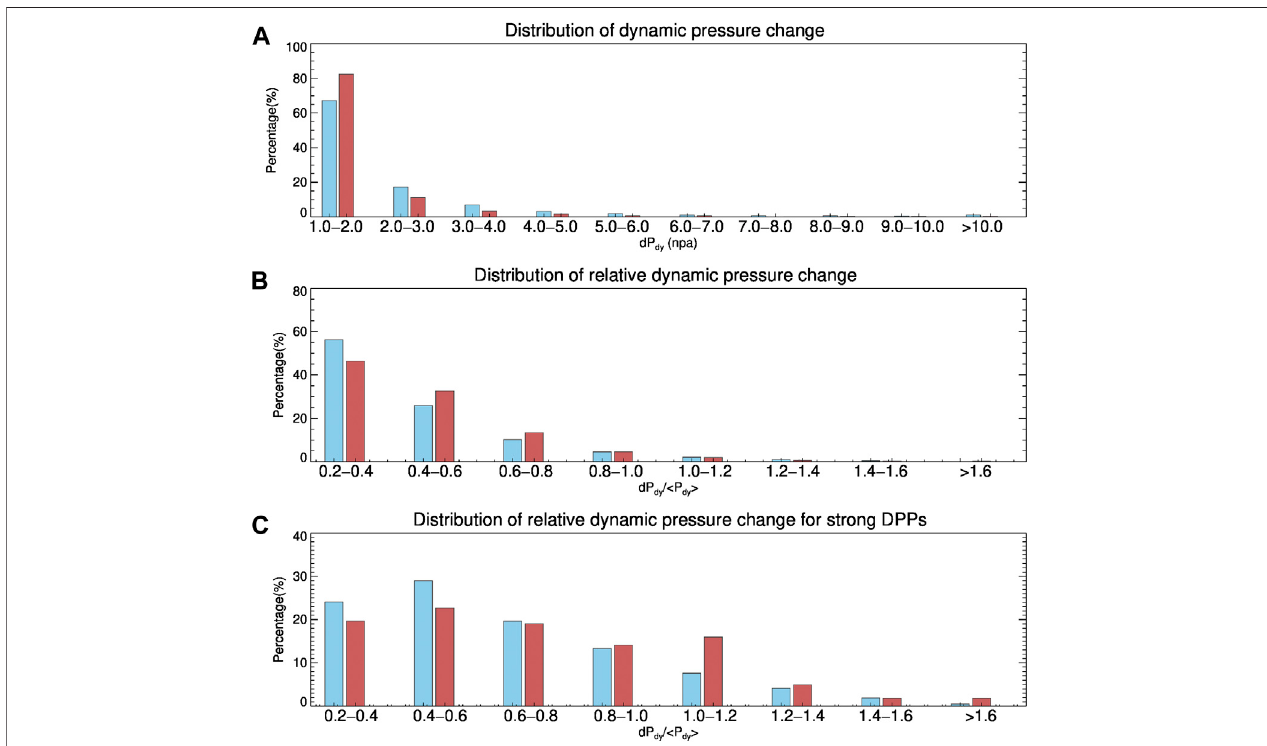
FIGURE 3 | The distributions of absolute dynamic pressure changes for all DPPs (A) , relative pressure changes for all DPPs (B) and relative pressure changes for strong DPPs (C) in the undisturbed solar wind (indian red) and solar wind transients (sky blue).